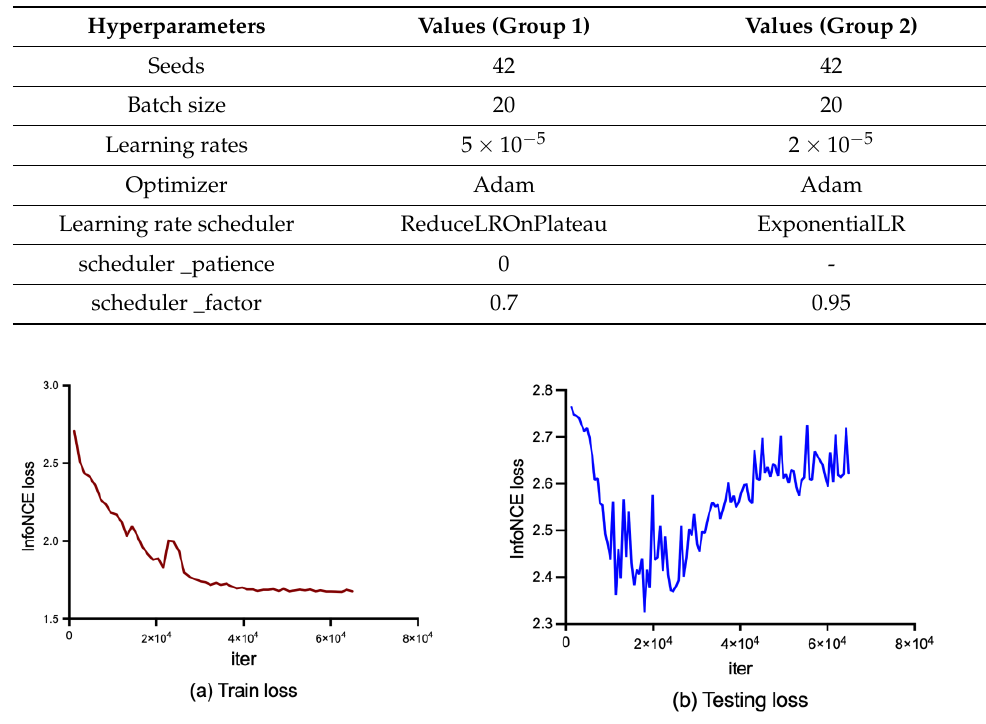
Figure 11. Train and test loss using InfoNCE loss, group 1: ( a ) the train loss; ( b ) the test loss; the model is overfitting after nearly 2 × 10 4 batch iterations. The lowest values of the test loss are nearly 2.32 at the 18029th batch iterations. This is the lowest value we could achieve in countless attempts.